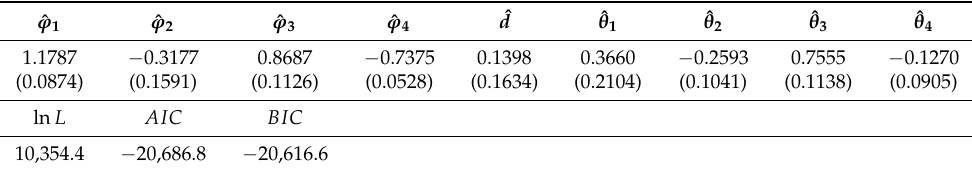
Table 2. Estimation results of the ARFIMA ( p , d , q ) model. Standard errors in parentheses.